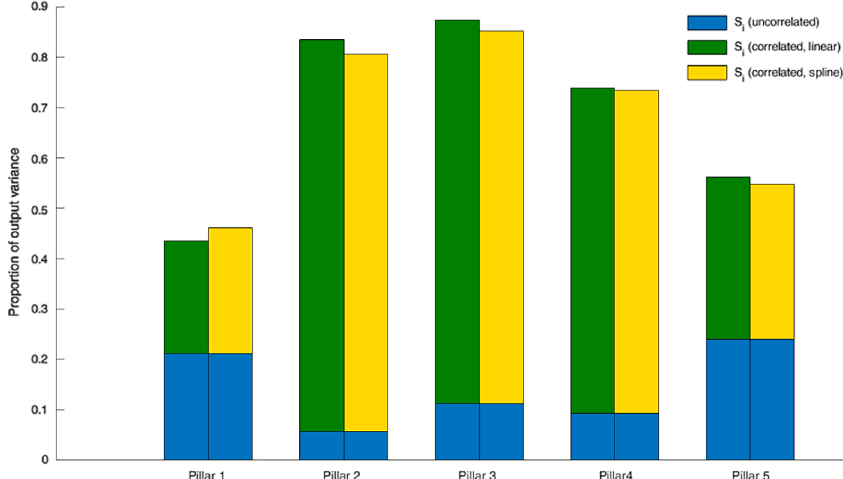
Figure 9. Penalized splines estimates of S i (total bar) broken down into U i S (blue bar) and C i S (green or yellow bar)* in DESI 2020 edition. *Green – linear spline regression model, yellow – non-linear spline regression ( Table 2. Penalized splines estimates of S i broken down into uncorrelated part Linear Non-linear Dimension